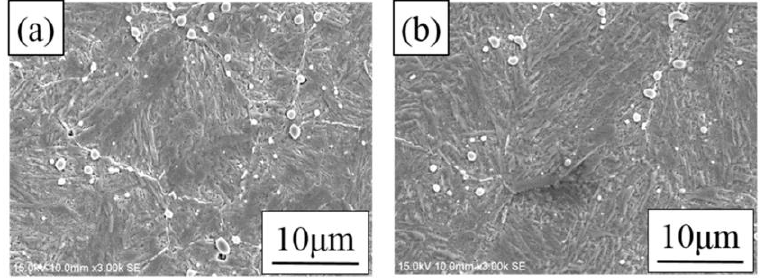
Figure 5. Microstructure of as-quenched modified 440A MSS at a temperature of 1050 °C, taken from the ( a ) quarter and ( b ) center areas, respectively.